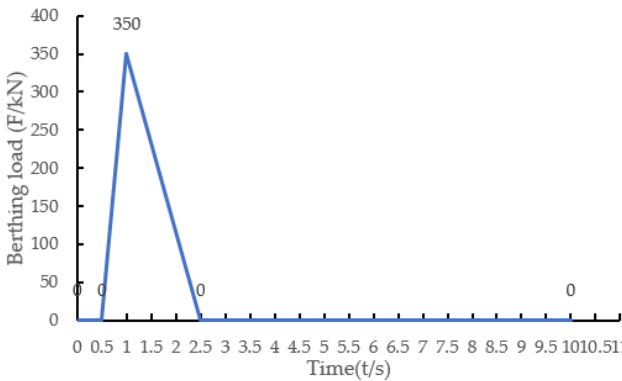
Figure 3. Schematic diagram of ship loading time course.